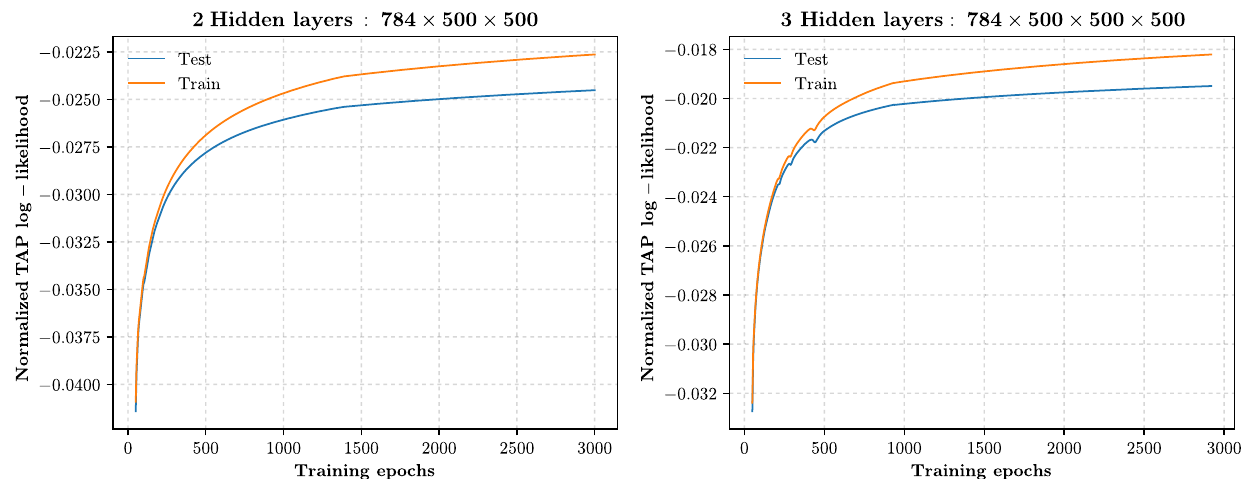
FIG. 11. Training performances over 3000 training epochs for a two-hidden-layer (left) and a three-hidden-layer (right) DBM on the binarized MNIST data sets. Both models are pretrained for 50 epochs with the same learning rate of 0.001. The training performance is measured as the normalized (per unit) TAP log-likelihood for the test images (blue curve) and the train images (orange